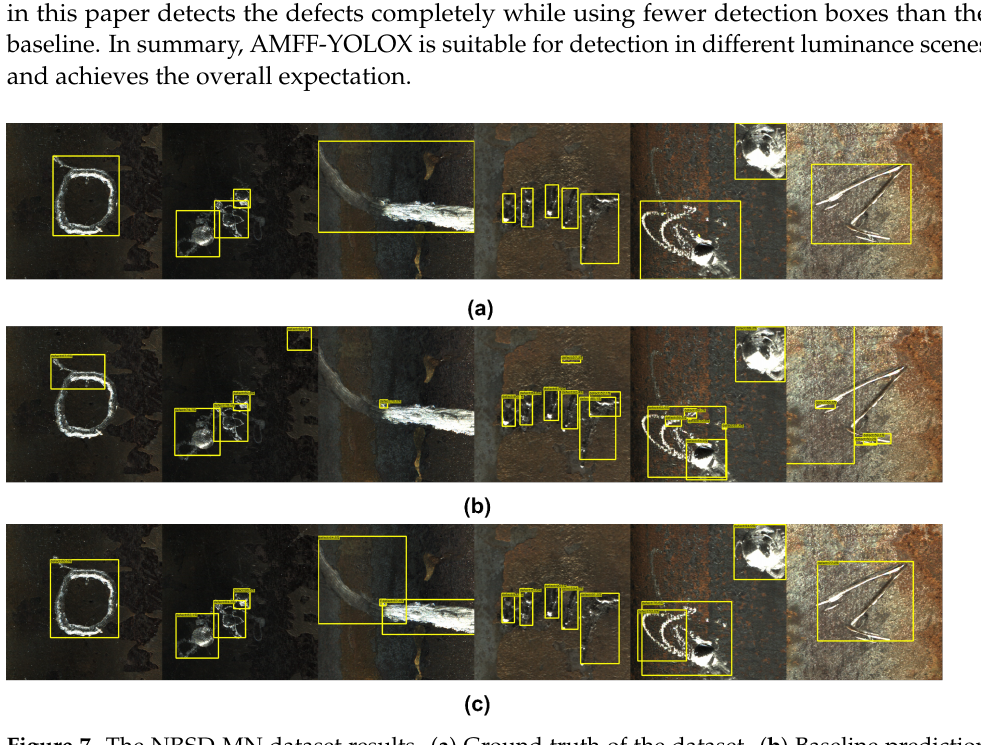
Figure 7. The NRSD-MN dataset results. ( a ) Ground truth of the dataset. ( b ) Baseline prediction label. ( c ) Model prediction label of this